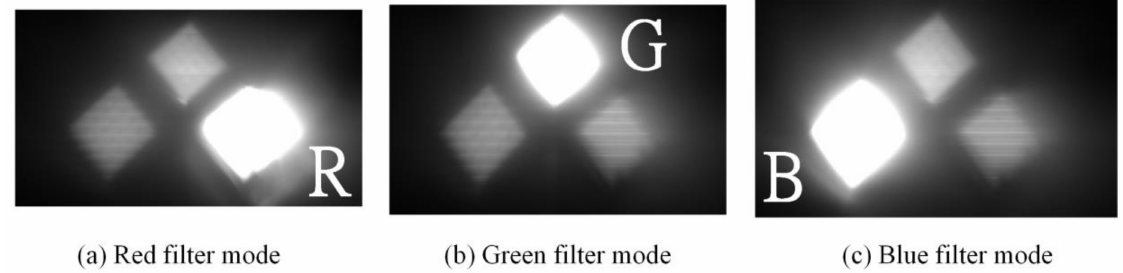
Figure 5. Received lights at OT_Rx without adding physical bandpass optical filters.